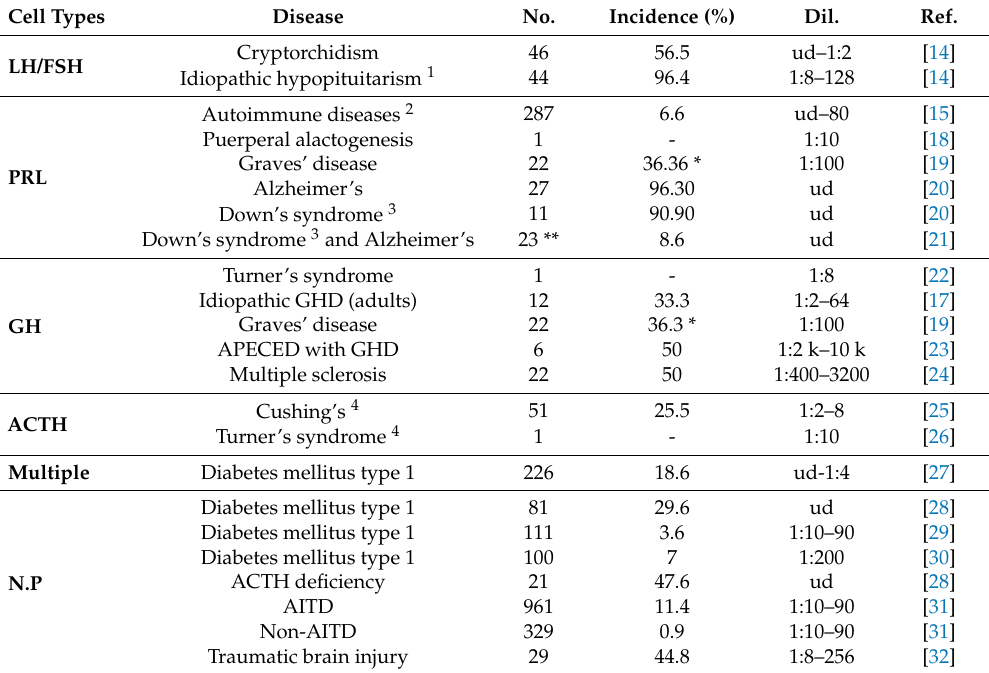
Table 1. Incidence of APAs in autoimmune and no-autoimmune